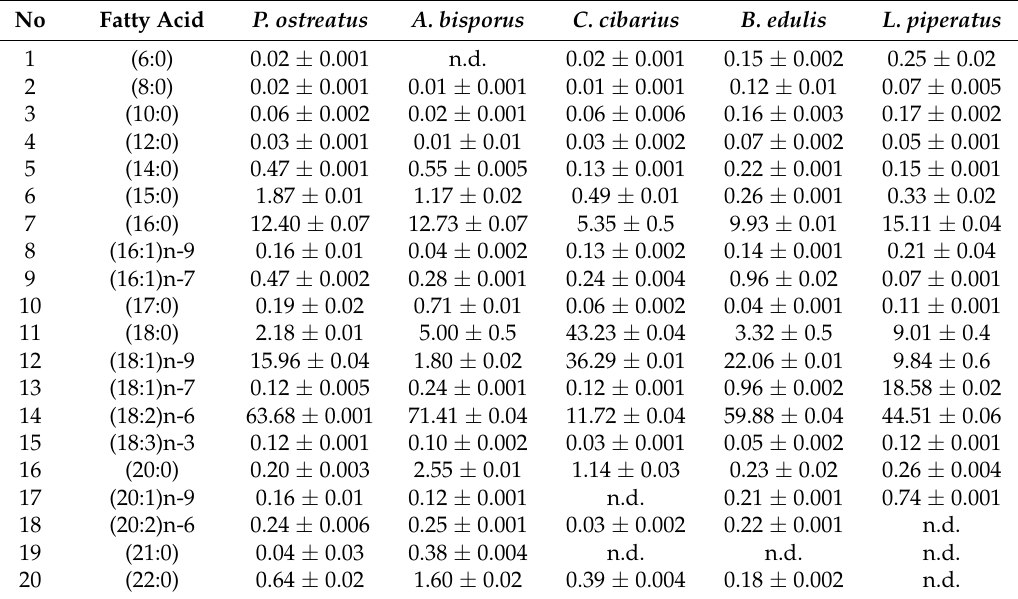
Table 2. Fatty acid composition (%) of the selected Transylvanian